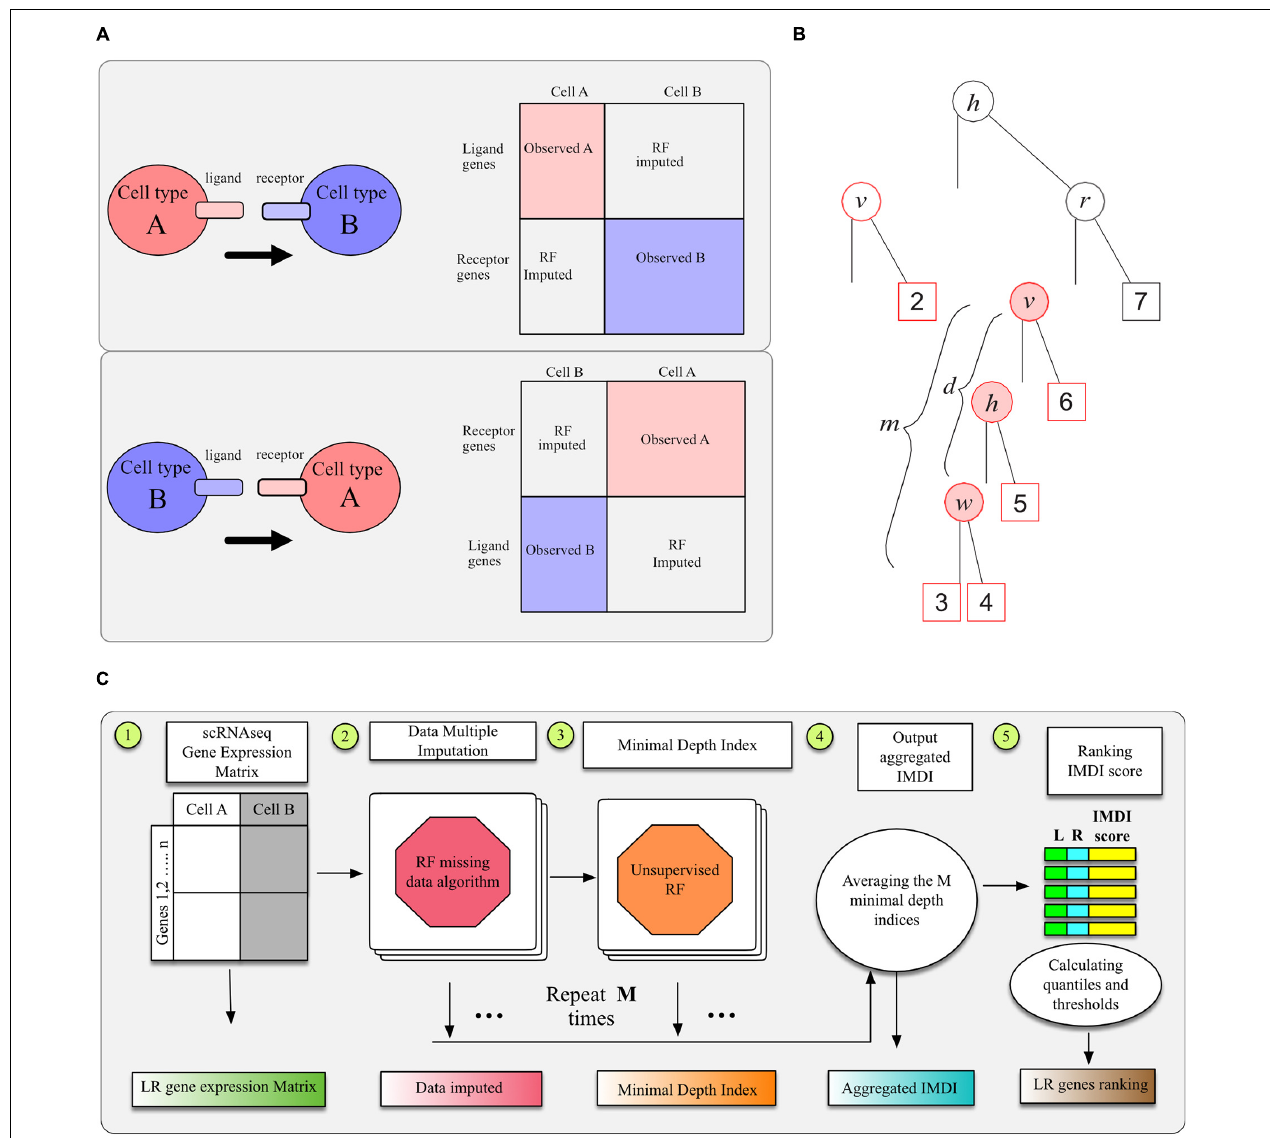
FIGURE 1 | Illustration of RF methods. (A) Data sheet and imputation illustration. (B) The minimal depth of w in a maximal v -subtree. Letters in parent nodes identify the variable used to split the node. There are two maximal v -subtrees, marked in red. The maximal v -subtree on the left side is with terminal nodes 1 and 2; that on the right side is with terminal nodes 3, 4, 5, and 6. The minimal depth of w in the second maximal v -subtree is the depth of w ( d = 2 marked with pink background) normalized by the subtree depth ( m = 3), which is d/m = 2/3. (C) Model workflow for LR